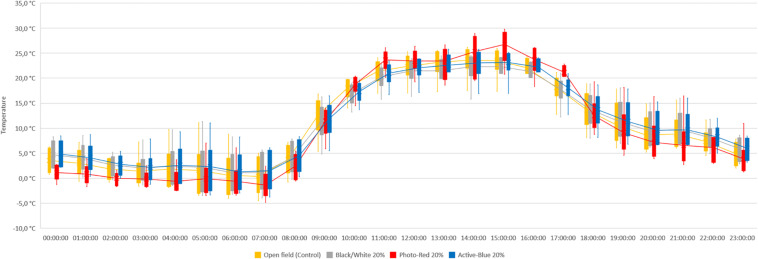
Temperature recorded under photo-selective nets during a warm spell in winter. Data were collected hourly for a week. The horizontal middle line represents the median that goes through the mean of each box. The whiskers (vertical lines) extend from the ends of the box to the minimum value and maximum value.